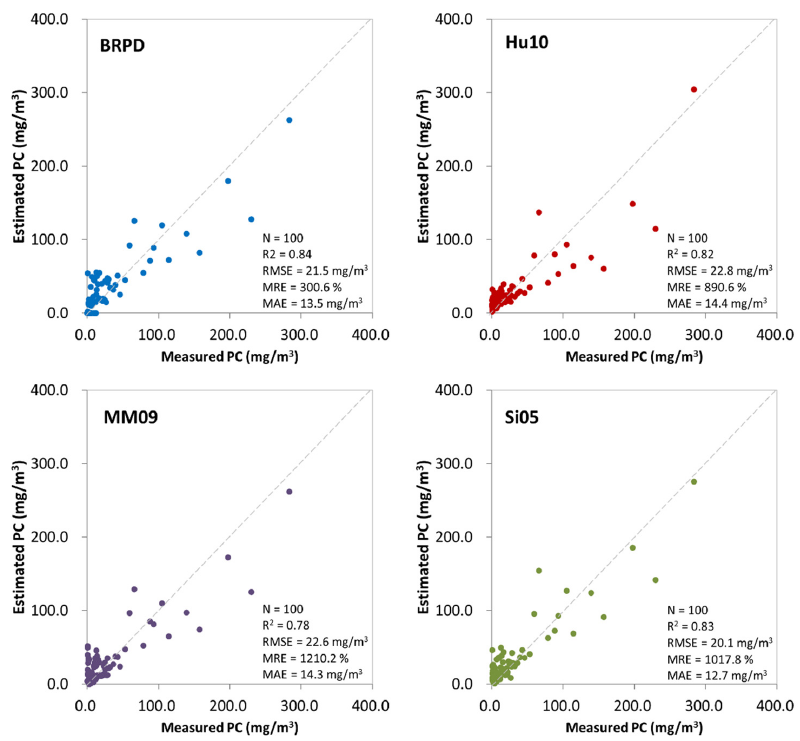
Figure 6. Results obtained by applying four different algorithms to the validation datasets. Similar to the results of the calibration case, BRPD performed better than the other three methods in all of the error indices except the RMSE and MAE values, which were slightly higher than those of